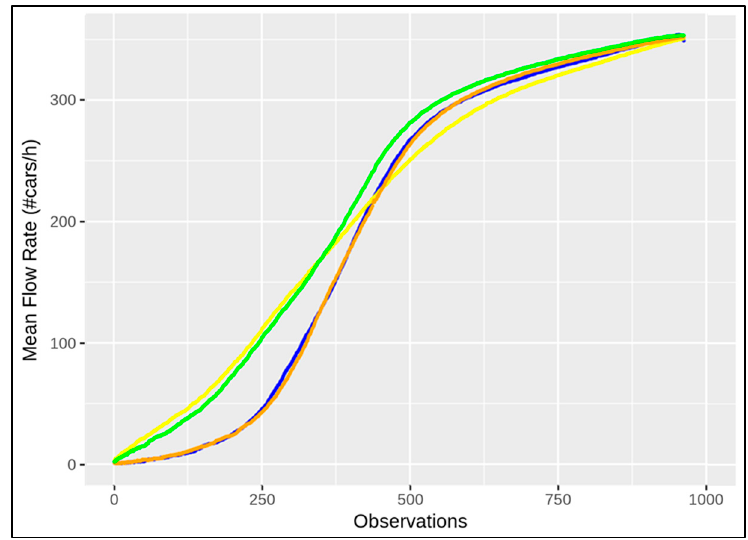
Figure 7. The seasonal changing curves are shown in terms of MFR, where the behaviours of the seasons are depicted in blue (March), green (May), yellow (July), and orange (October).